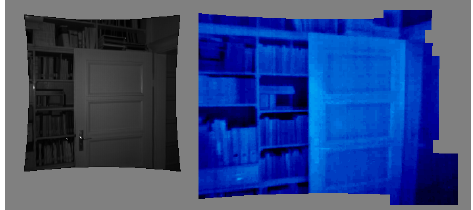
Figure 7: Passive intensity image and IR image after undistortion and after removal of irrelevant